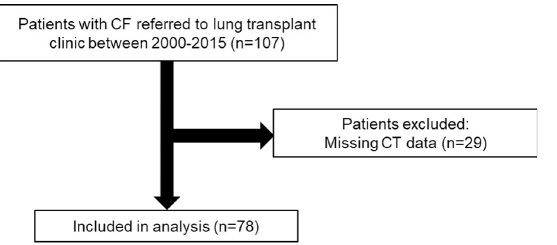
Fig 2. Study flow diagram. CF = cystic fibrosis. CT = contrast tomography. RHC = right heart